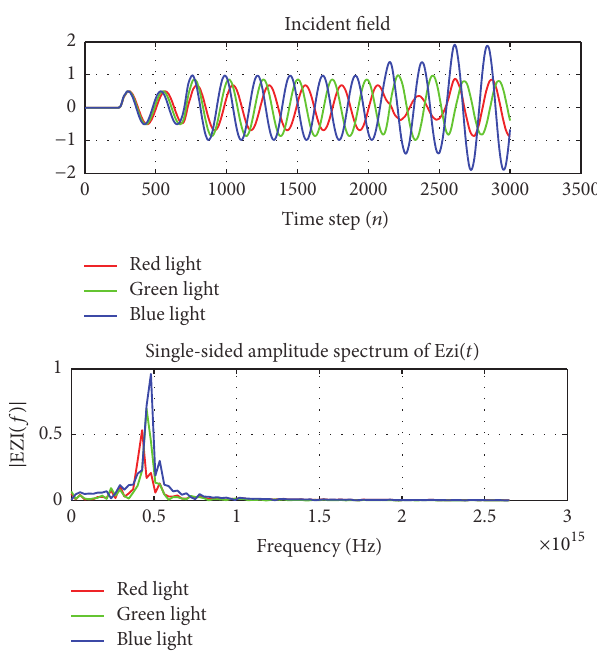
Figure 14: Incident field and equivalent amplitude spectrum versus frequency for red, green, and blue light corresponding to conditions in Table 5.